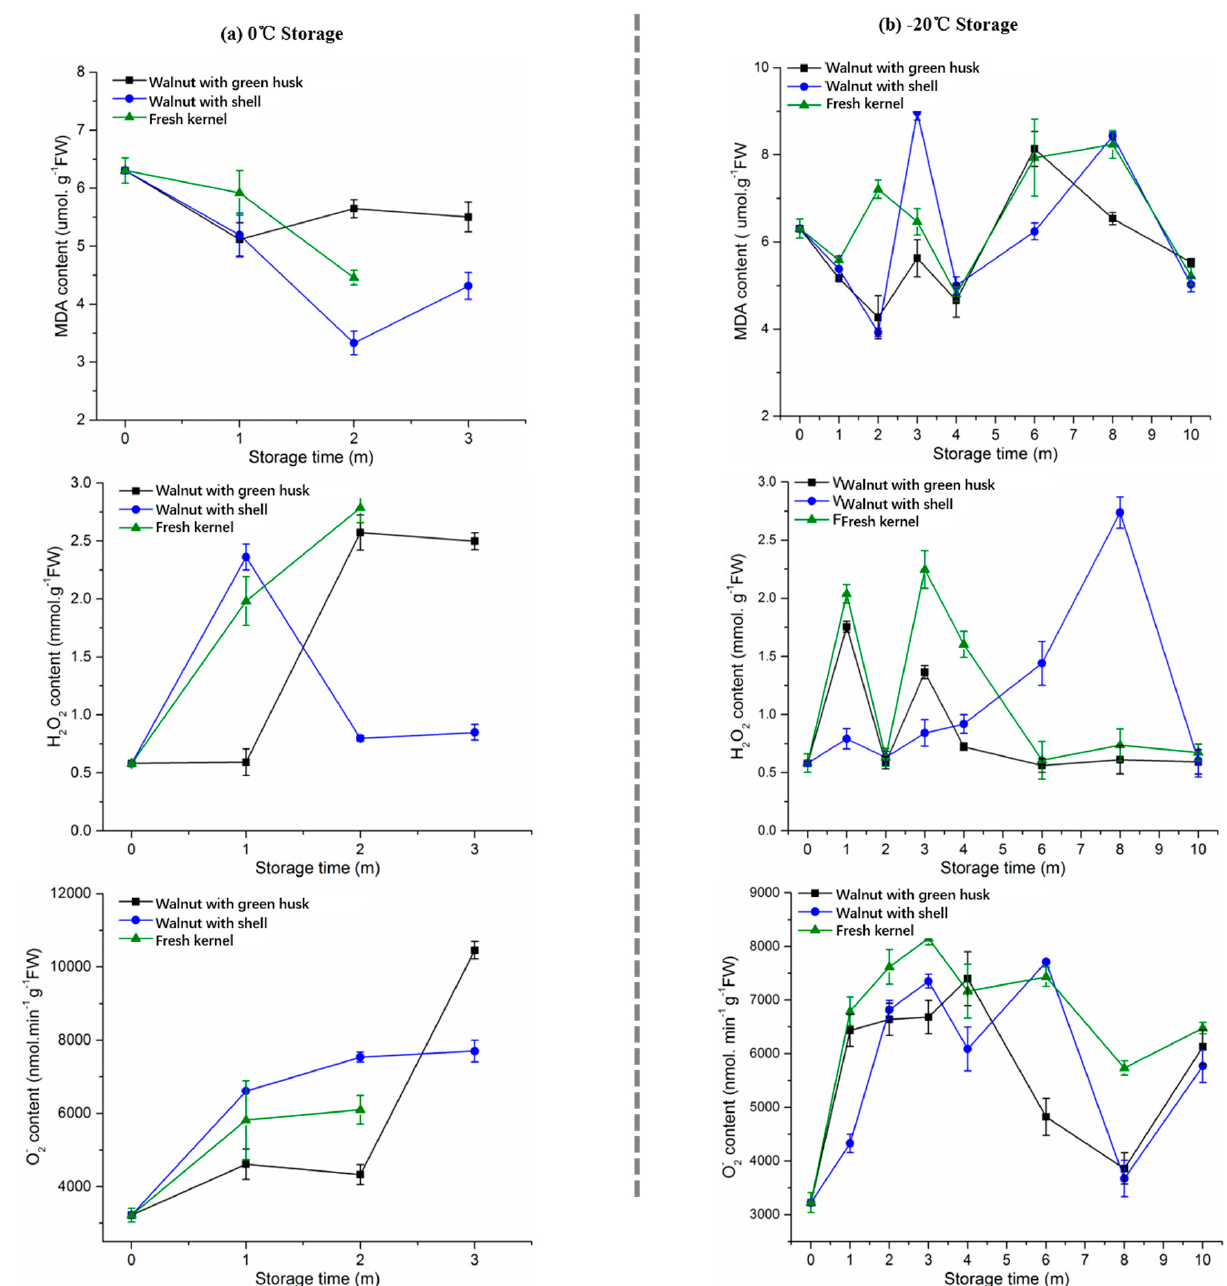
Figure 4. MDA, H 2 O 2 , and O 2 − production of walnut kernel under different storage conditions: ( a ) 0 °C and ( b ) − 20 °C. Note: m means month in the figure.